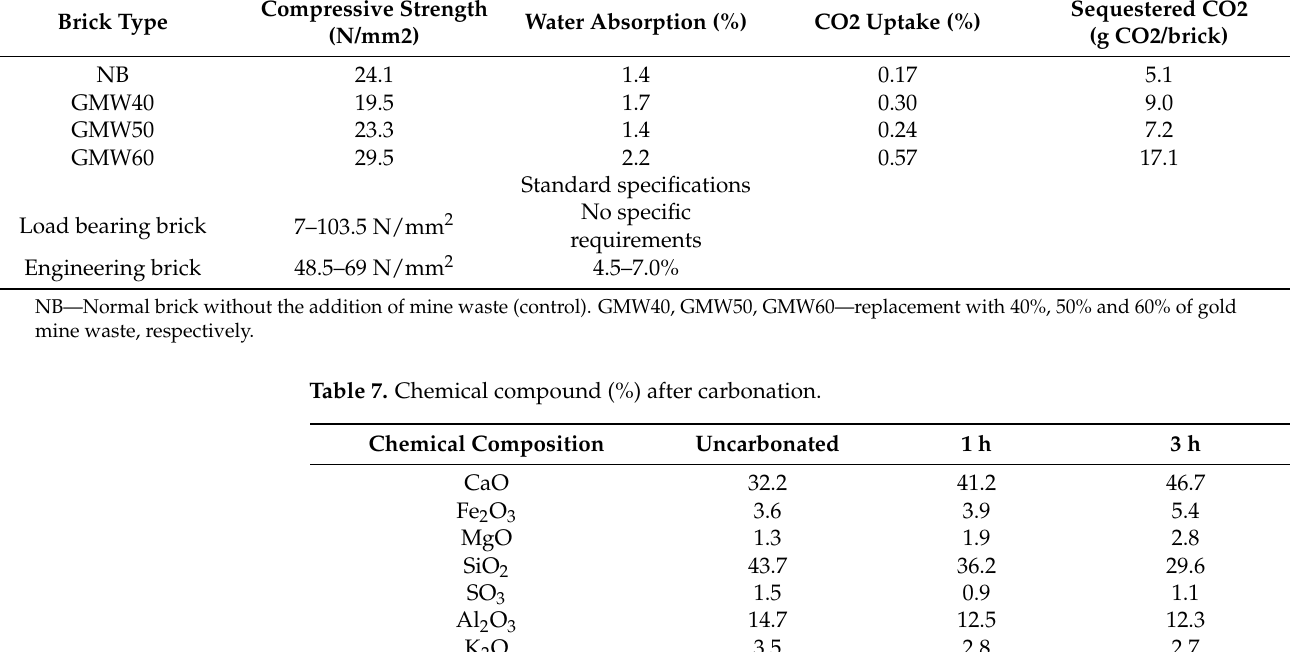
Table 6. Criteria of the cement-based product (bricks) and sequestered CO 2 in carbonated brick product at 1 h carbonation. Brick Type